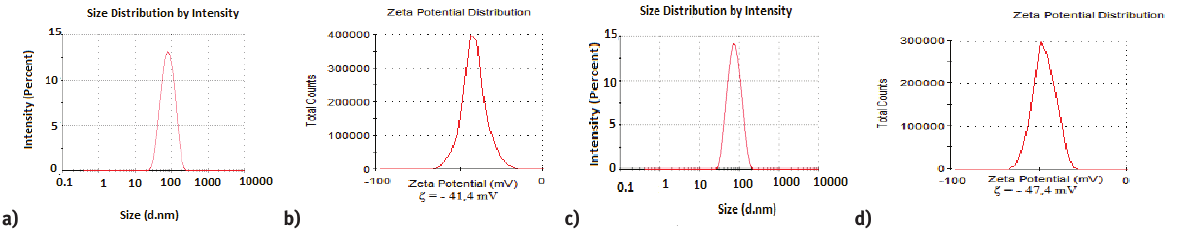
Figure 4. Size distribution and Zeta potential for Ag-TiO 2 NPs (a,b) and for Ag-N-TiO 2 NPs (c,d) in aqueous dispersions Figure 4: Size distribution and Zeta potential for Ag-TiO